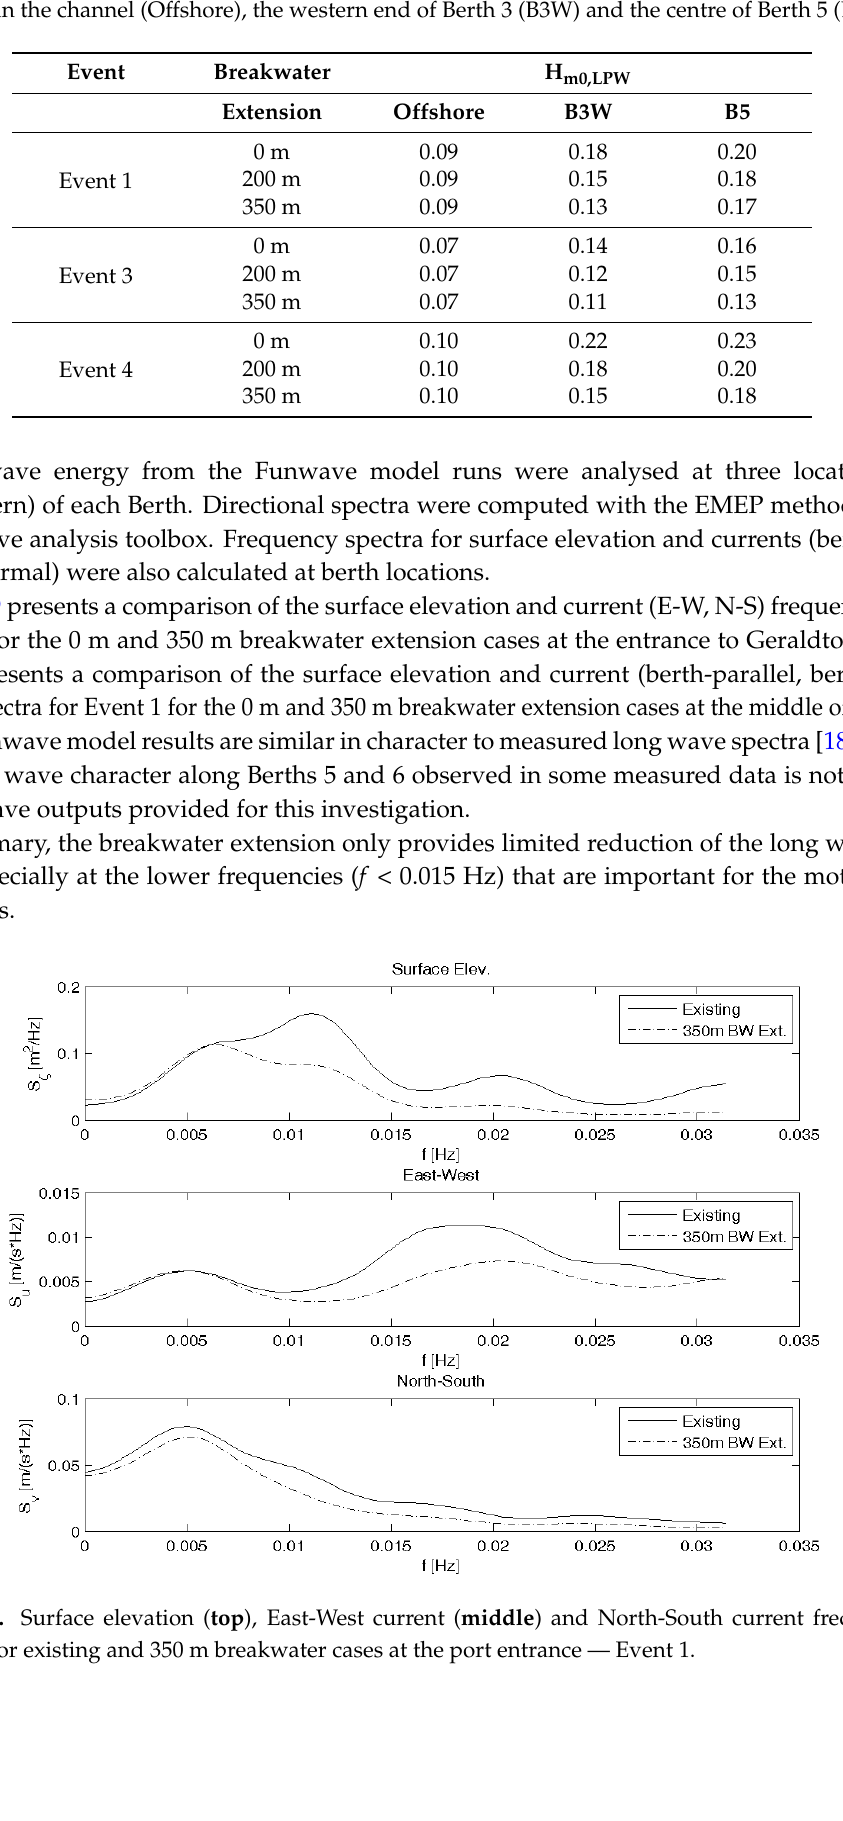
Figure 10. Surface elevation ( top ), Berth Parallel ( X ) current ( middle ) and Berth Normal ( Y ) current frequency spectra for existing and 350 m breakwater cases at middle of Berth 5 — Event 1.